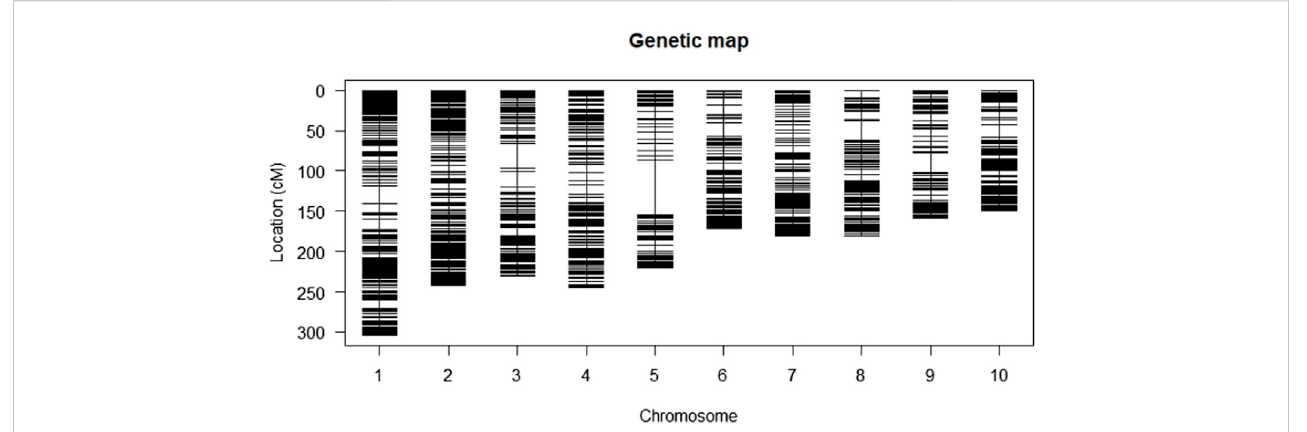
FIGURE 3 Genetic map constructed using DArT markers from the F 2:3 mapping population.